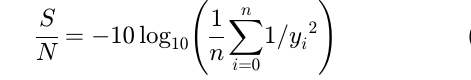
Table 4. Results obtained from hardness, impact and tensile tests for L Test no.